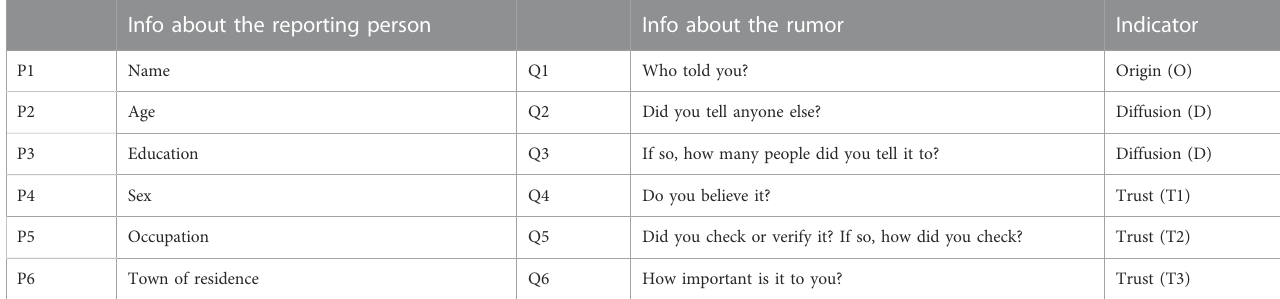
TABLE 1 Information requested when submitting a rumor report to characterize both the population sample and the collected rumor.